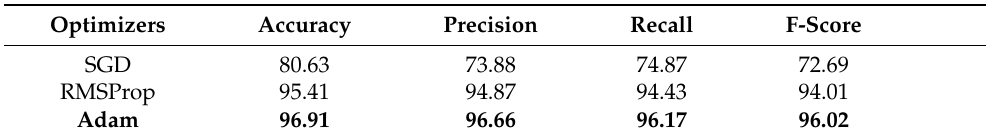
Table 1. Average recognition performance of the proposed convolutional neural network with ReLU activation function and different optimization methods on the UPCV dataset. The best performance is shown in bold.